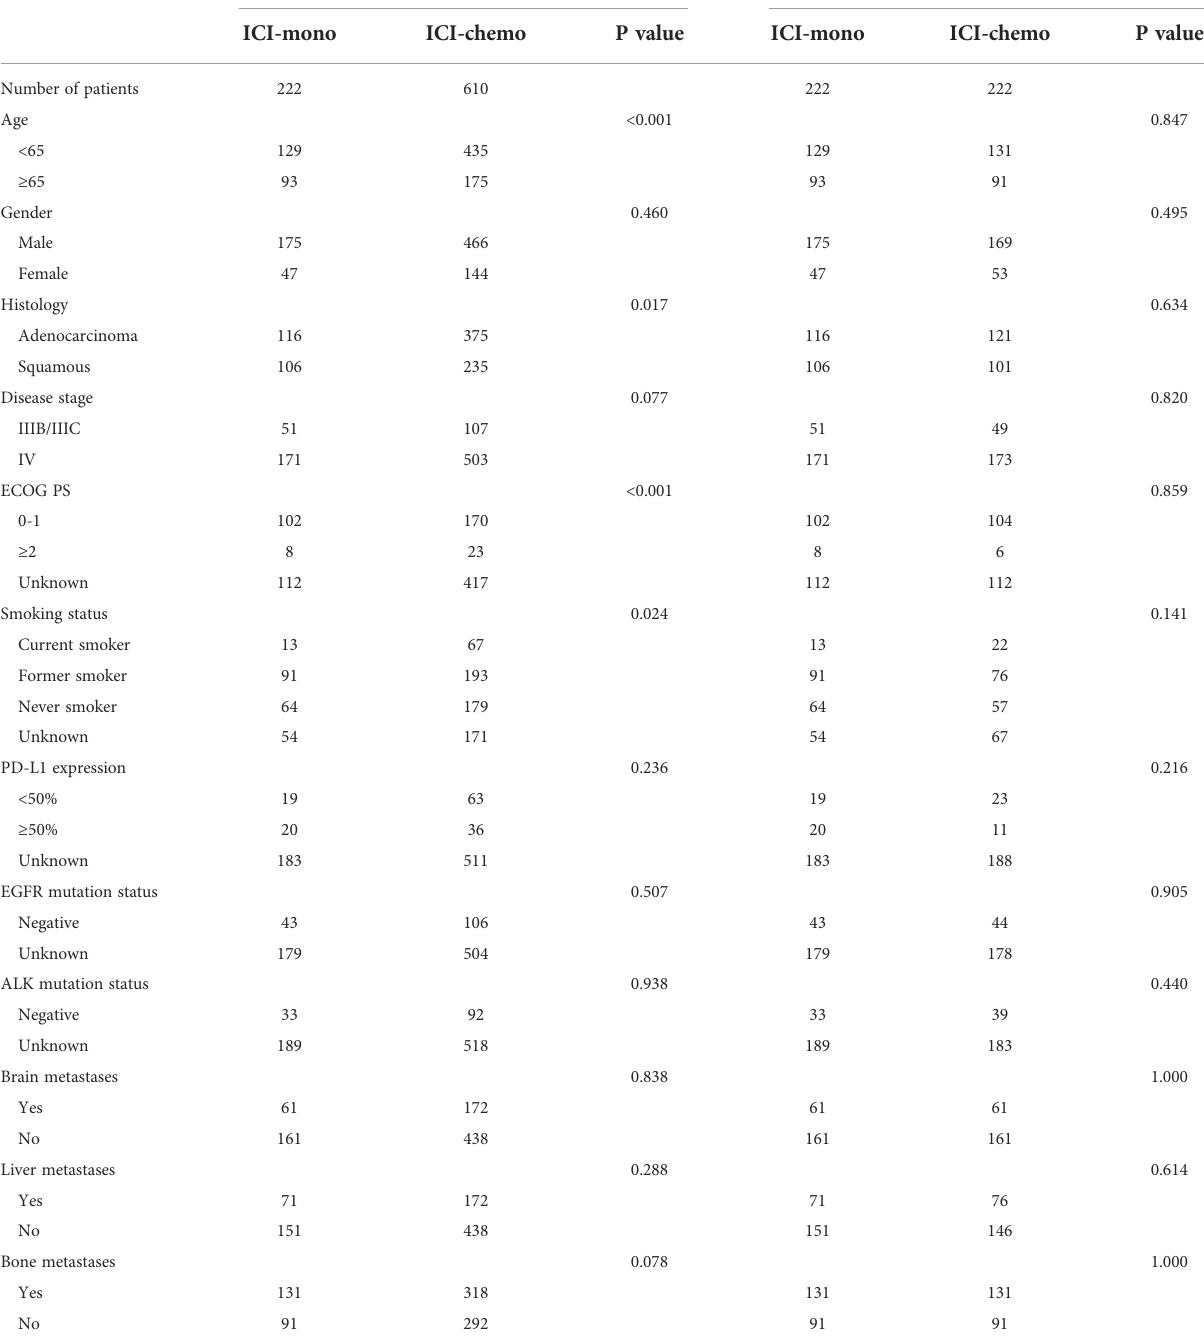
TABLE 1 Baseline characteristics of the initial cohort and the matched